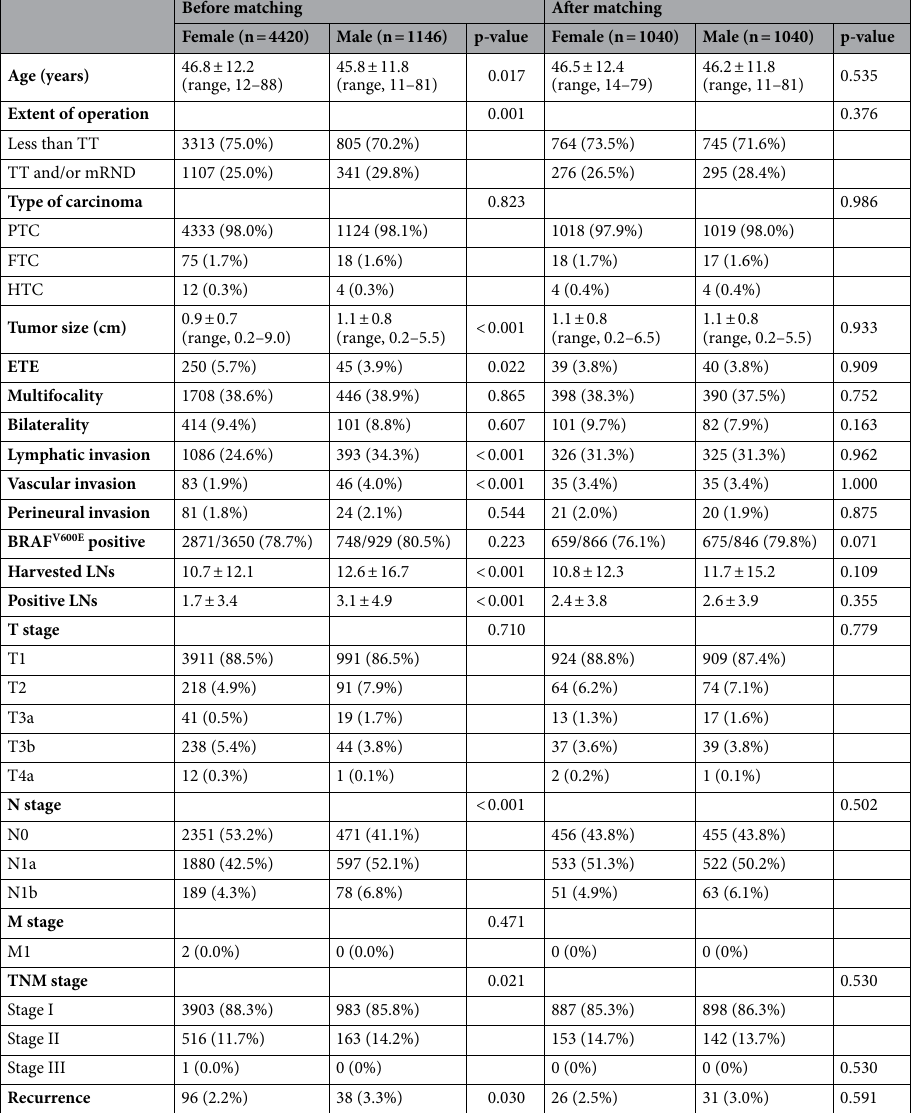
Table 1. Comparison of clinicopathological characteristics between females and males before and after propensity score matching. Data are expressed as patient’s number (%), or mean ± SD. A statistically significant difference was defined as p < 0.05. TT total thyroidectomy, mRND modified radical neck dissection, PTC papillary thyroid carcinoma, FTC follicular thyroid carcinoma, HTC Hürthle cell thyroid carcinoma, ETE extrathyroidal extension, LN lymph node, T tumor, N node, M